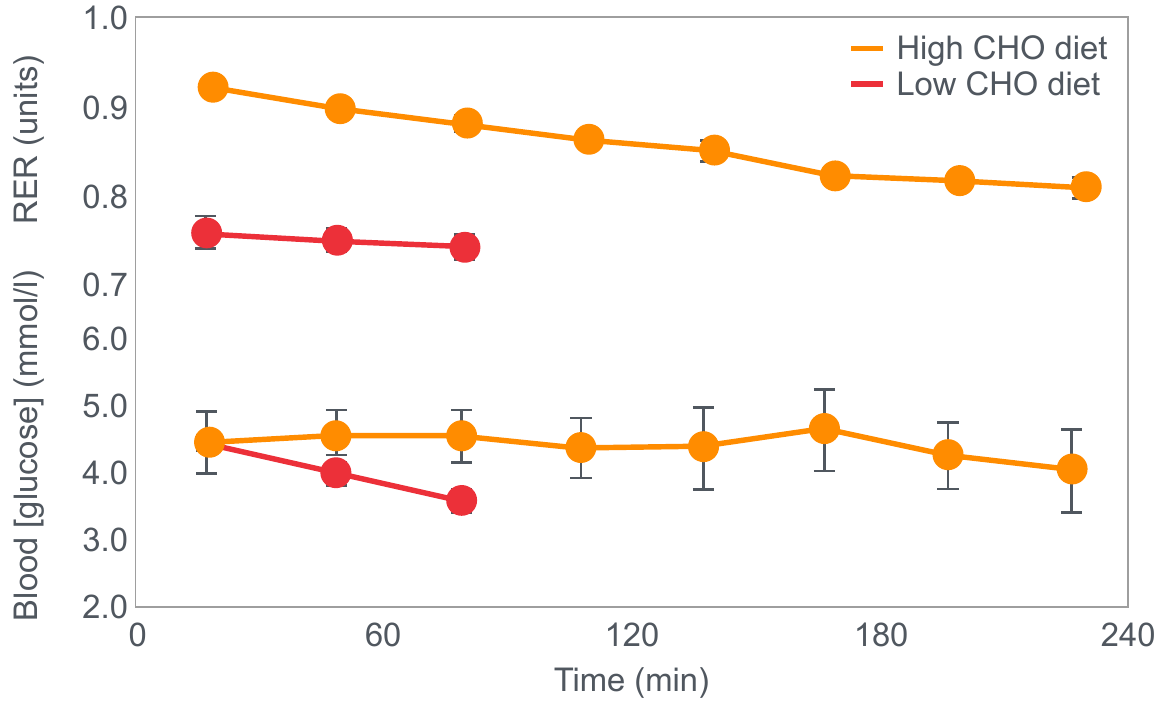
Nutrients 2022 , 14 , x FOR PEER REVIEW